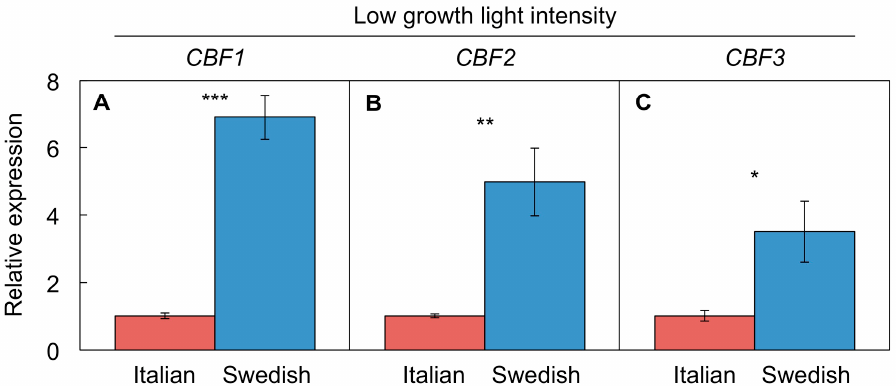
Figure 5. Relative expression (with mean transcript values for the Italian ecotype set to 1) of ( A ) CBF1 ( AT4G25490 ), ( B ) CBF2 ( AT4G25480 ), and ( C ) CBF3 ( AT4G25470 ) genes from leaves of Italian (Castelnuovo-12 [ABRC stock number: CS98761], sub-line 24) and Swedish (Rodasen-47 [ABRC stock number: CS98762], sub-line 29) ecotypes of A. thaliana grown under low light intensity (9-h photoperiod of 100 µmol photons m − 2 ·s − 1 ) at warm temperature (25 °C/20 °C [light/dark] air temperature). Mean values ± standard deviation ( n = 4); significant differences ( t -test) indicated by asterisks—* = p < 0.05, ** = p < 0.01, *** = p < 0.001. Leaf discs of 0.73 cm 2 were homogenized in liquid nitrogen by bead beating and RNA was extracted and DNase-treated (Qiagen RNeasy Plant Mini Kit). cDNA synthesis was performed with 2 µg of DNase-treated RNA per sample (Qiagen Omniscript cDNA Synthesis Kit). Due to the sequence similarity of the three CBF genes, qPCR primers were designed using the NCBI Primer-BLAST Tool in order to minimize off-target amplification of paralogous genes. qPCR was performed with 40 ng of cDNA per sample (Applied Biosystem’s Fast Sybr Green Master Mix) and the housekeeping gene UBC21 ( AT5G25760 ) was used as a control.